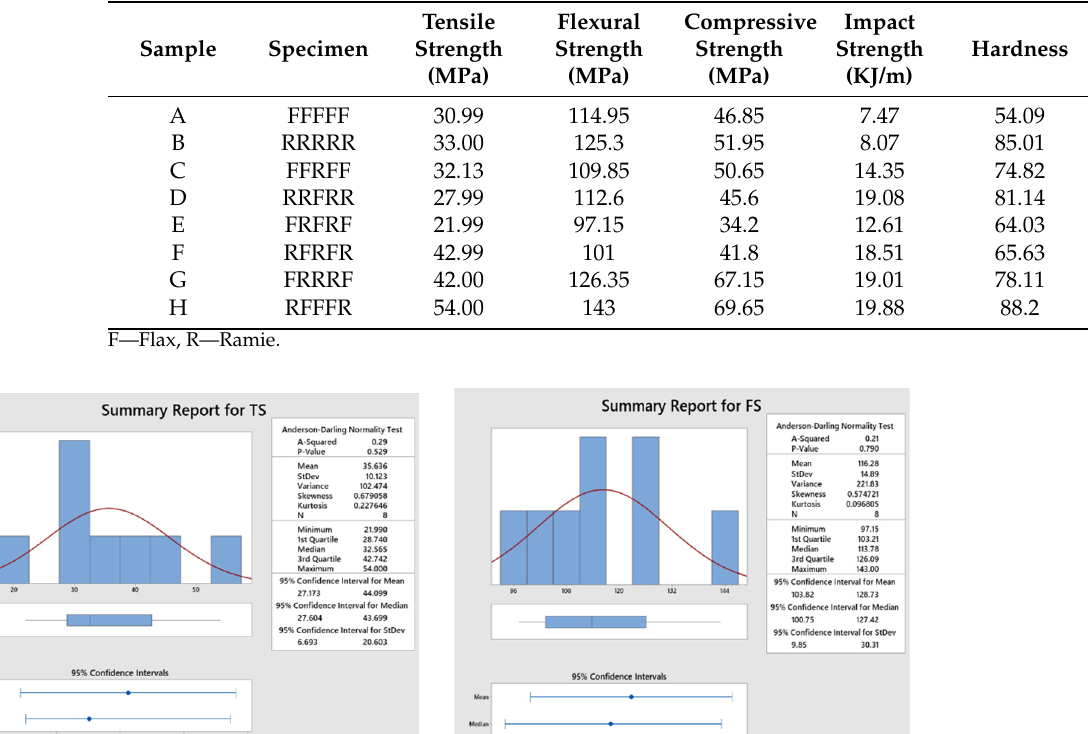
Table 3. Experimental result of Composite.